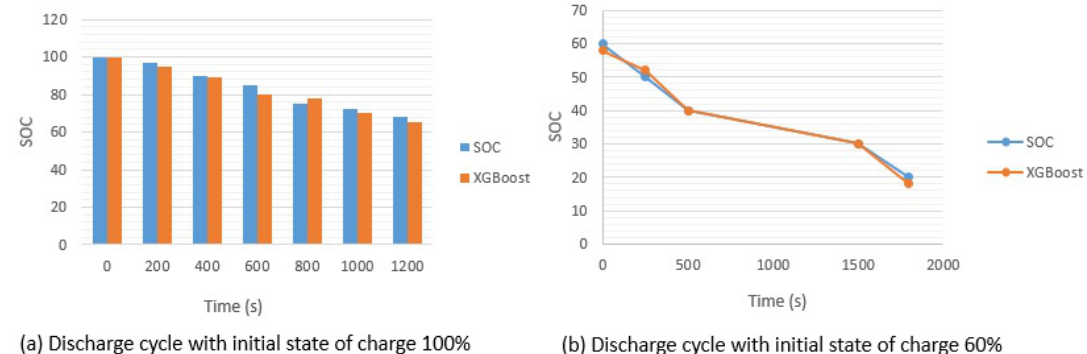
Figure 7. Charge cycle of the battery aging